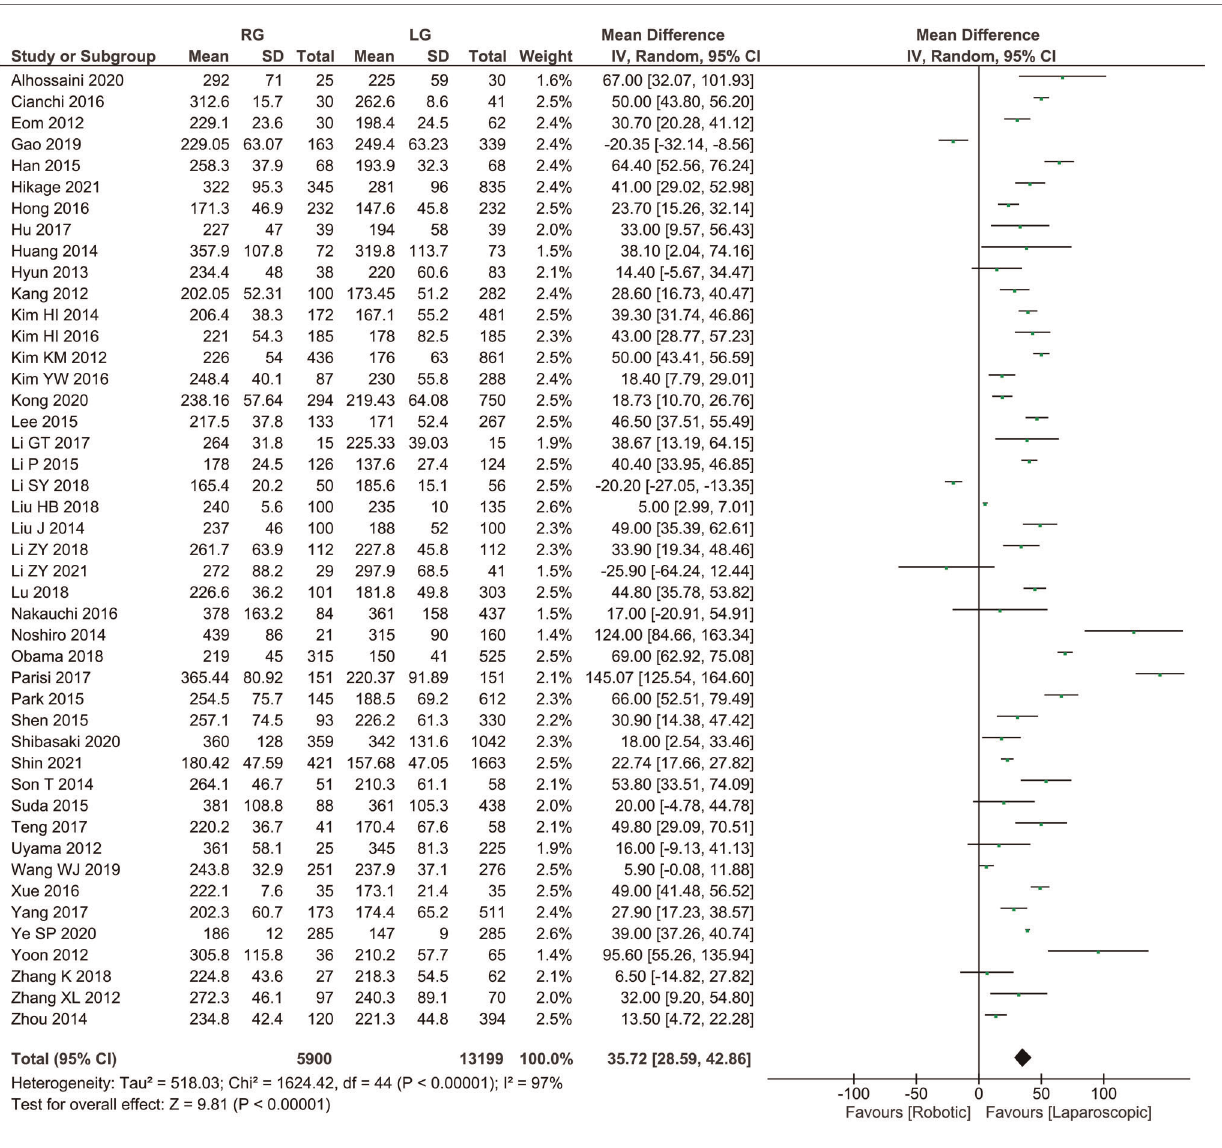
FIGURE 1 | Comparison of operation time between RG and LG